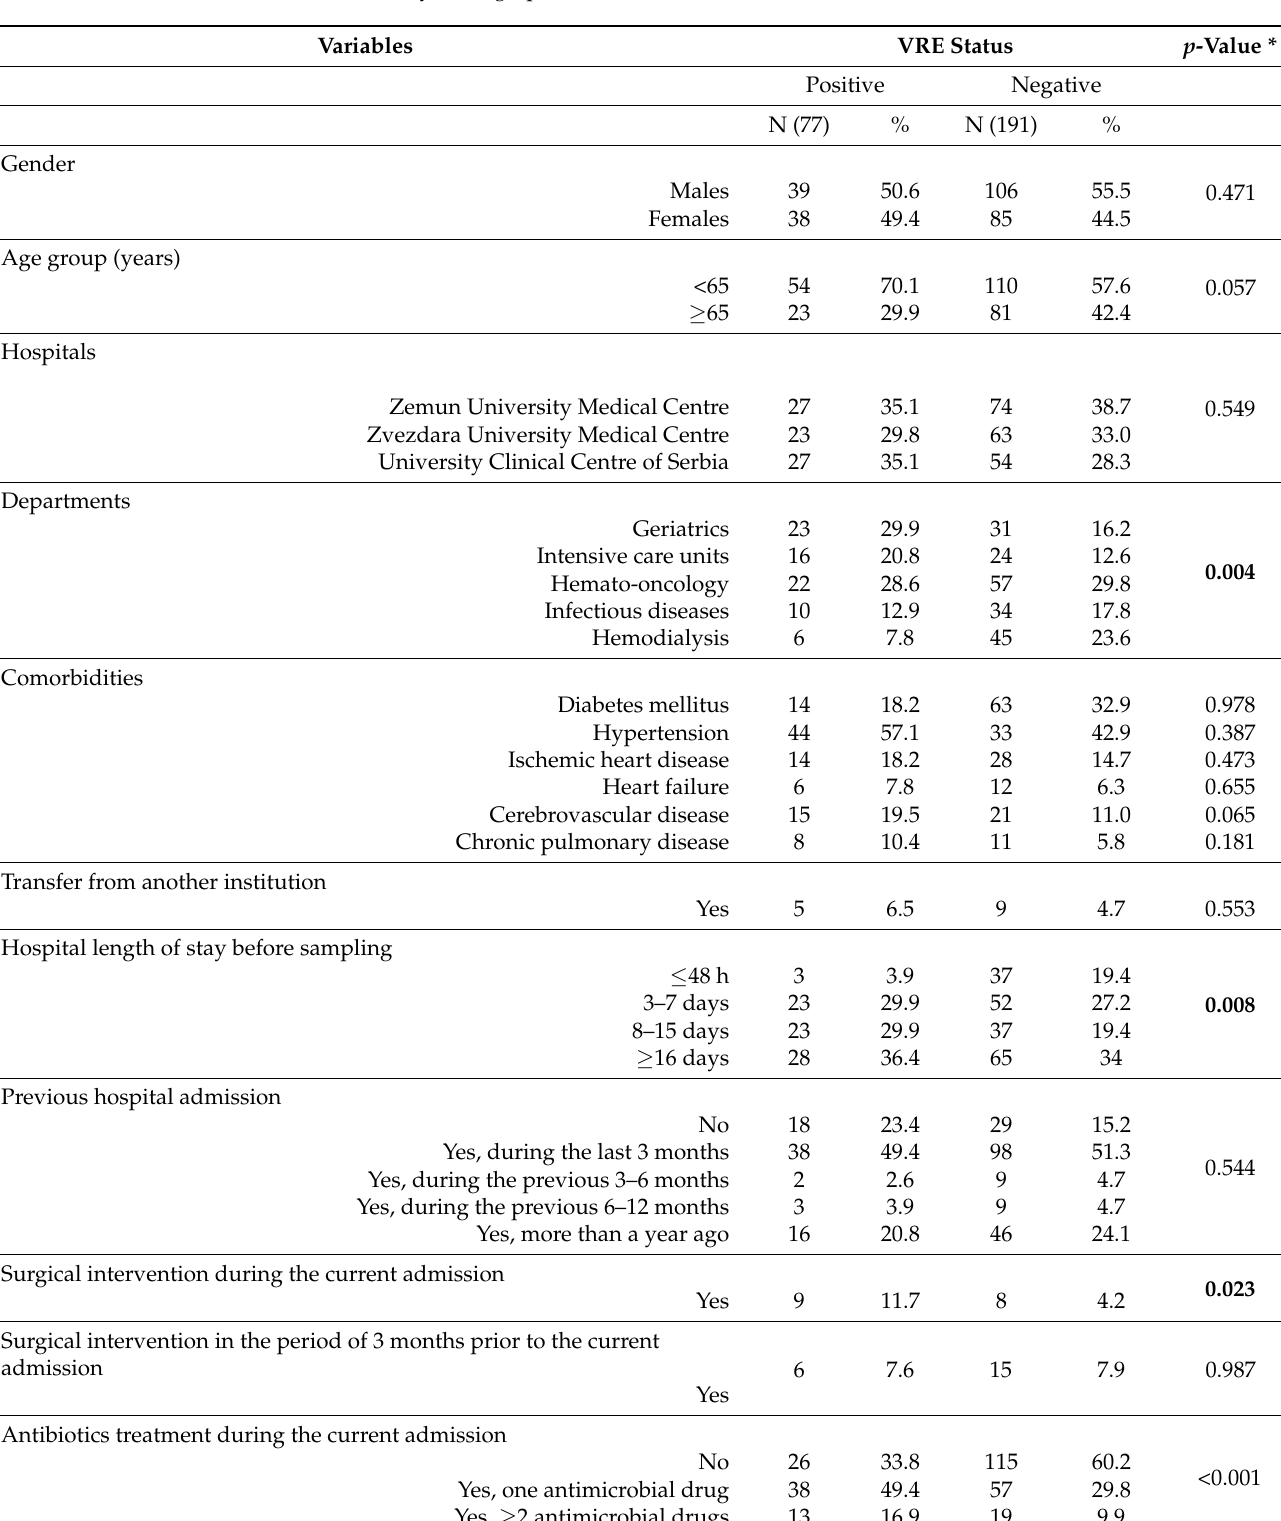
Table 1. Distribution of vancomycin-resistant Enterococcus spp. (VRE) carriers and VRE non-carriers stratified by demographic and clinical